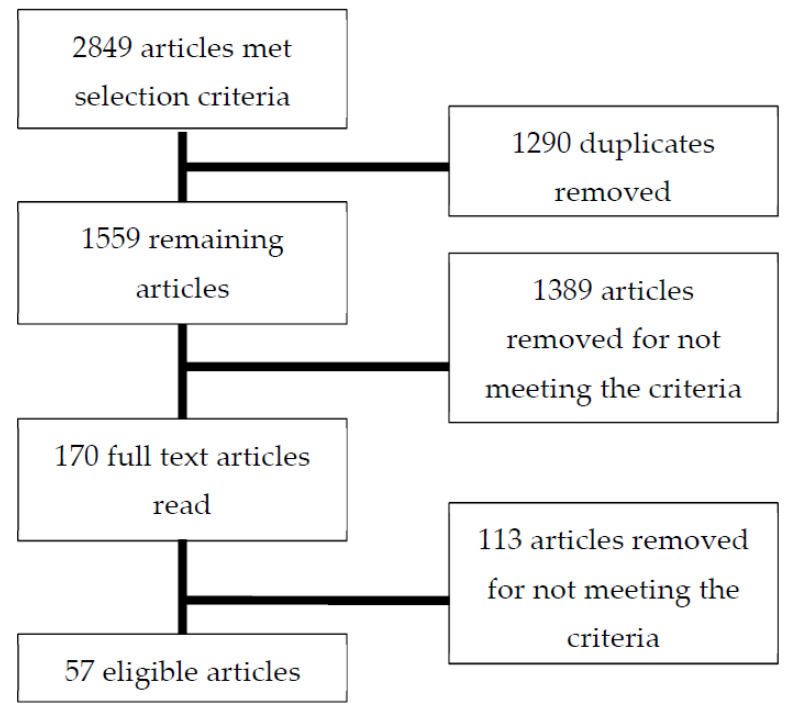
Figure 1. Flow chart of articles meeting search criteria, number of articles excluded, and final number of articles meeting inclusion criteria for review.